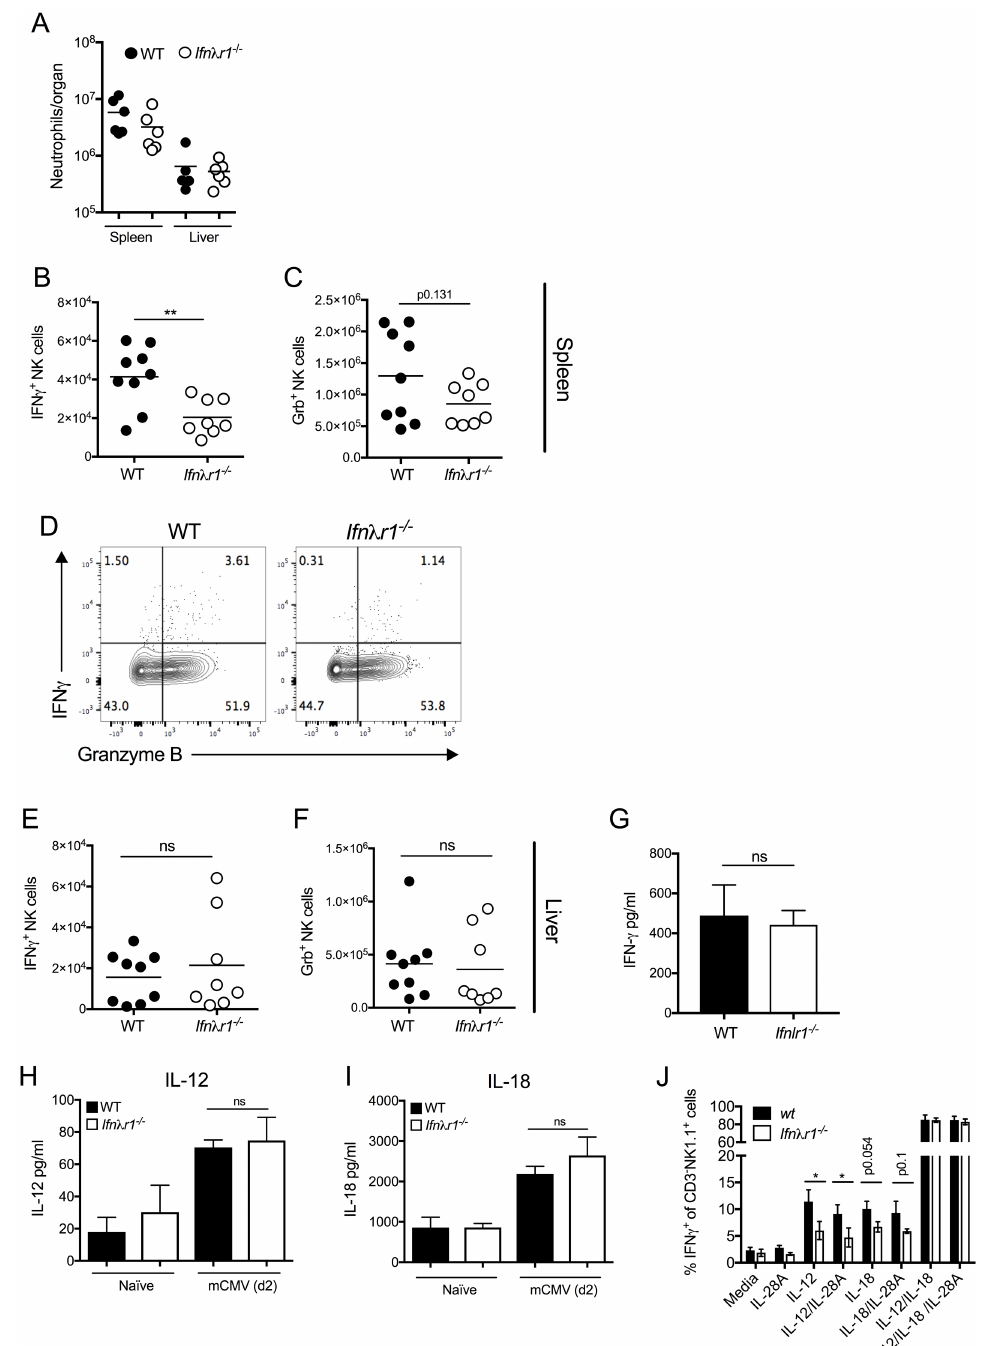
Fig 3. IFN λ promotes IFN γ + NK cell responses. (A) Neutrophil numbers in the spleens and livers of mCMV-infected WT and Ifn λ r1 -/- mice was assessed 4 days p.i. IFN γ + (B&D) and granzyme B + (C&E) NK cell accumulations in spleens (B-C) and livers (E&F) were quantified day 4 pi. Individual mice + mean is shown from 2 independent experiments and represent 4 (liver) or 5 (spleen) experiments in all. (D) Representative bivariant FACS plots of IFN γ versus granzyme B expression by live NK1.1 + CD3 - cells 4 days post-infection. Plots show concatenated samples from 4 (WT) and 6 ( Ifn λ r1 -/- ) mice. Results represent 3 experiments. (G) IFN γ protein in the serum was measured 4 days pi. Mean + SEM of 3–4 mice/group is shown. (H&I) IL-12 (H) and IL-18 (I) protein was measured in naïve spleen tissue or after 2 days of mCMV infection. Mean + SEM of 3 (naïve) or 7 (infected) mice is shown. (J) IFN γ expression by NK cells stimulated